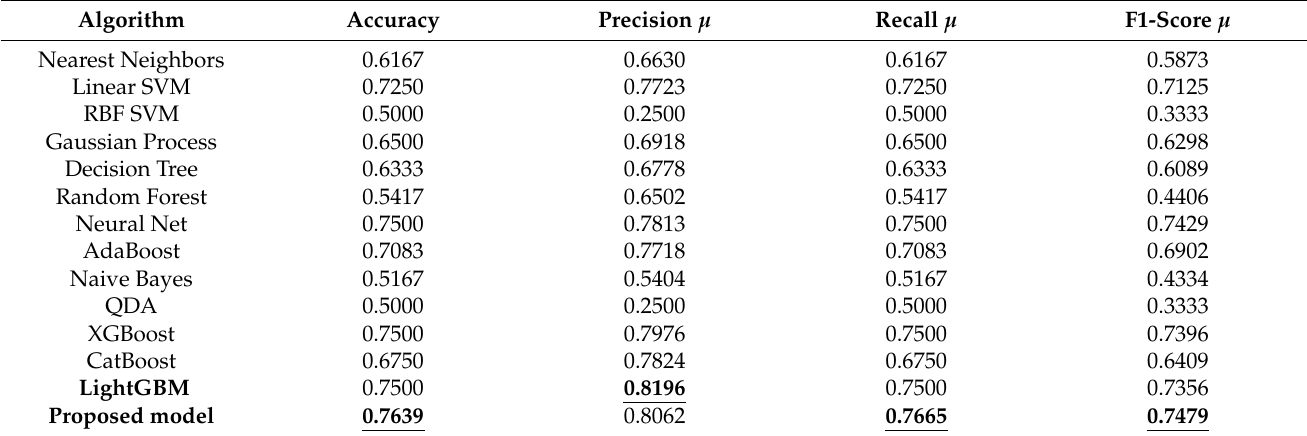
Table 10. Age classification of Yang DAO-8 rice